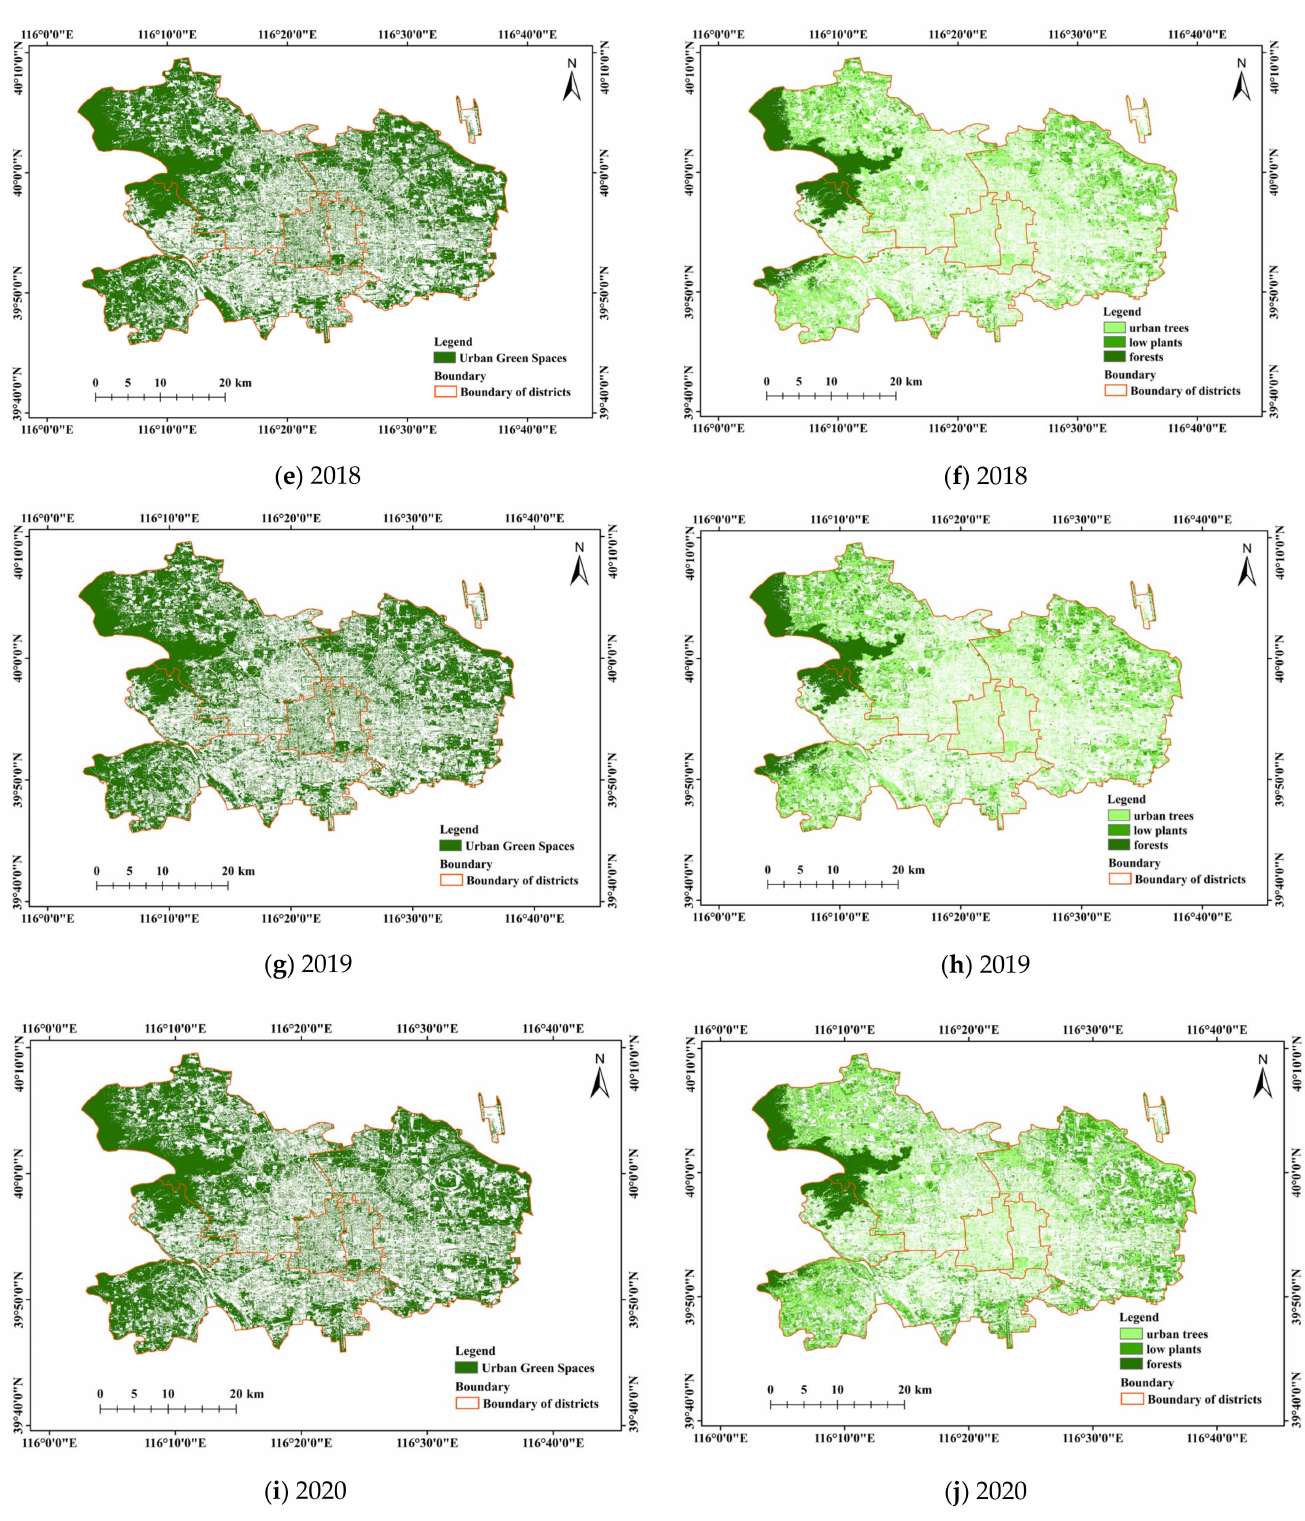
Figure 6. Extraction result ( a , c , e , g , i ) and classification result ( b , d , f , h , j ) of UGS in the center of Beijing from 2016 to